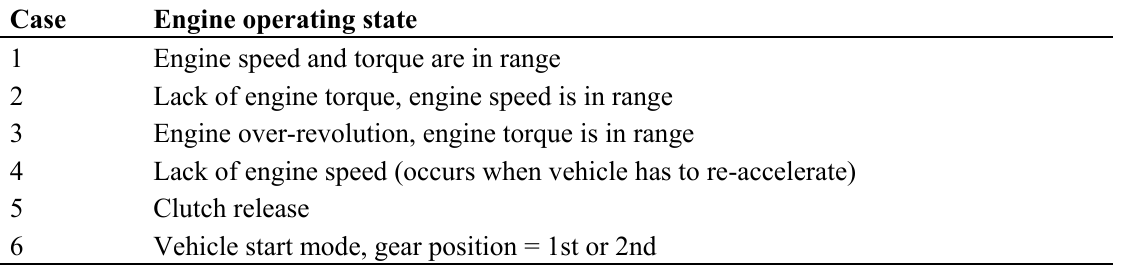
Table 1. Definitions of engine operating states in simulation